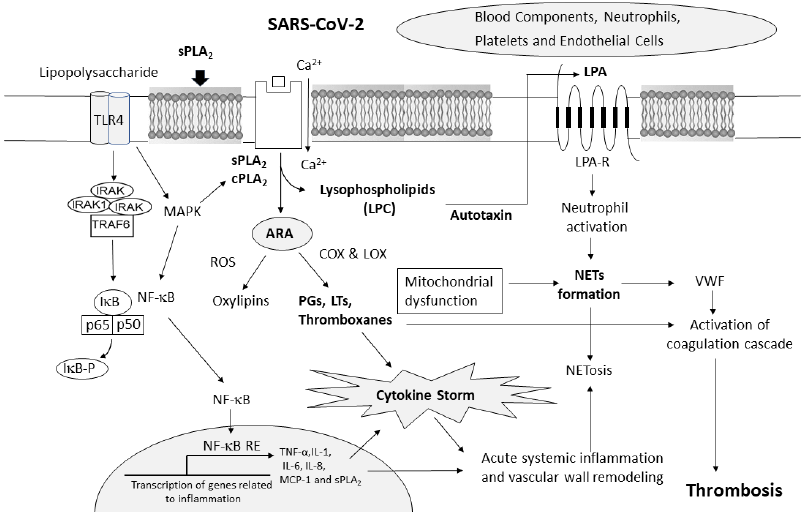
Figure 2. Concept of lysophosphatidic acid generation, the release of NETS, and how these processes contribute to inflammation and increased thrombosis risk following SARS-CoV-2 infection.